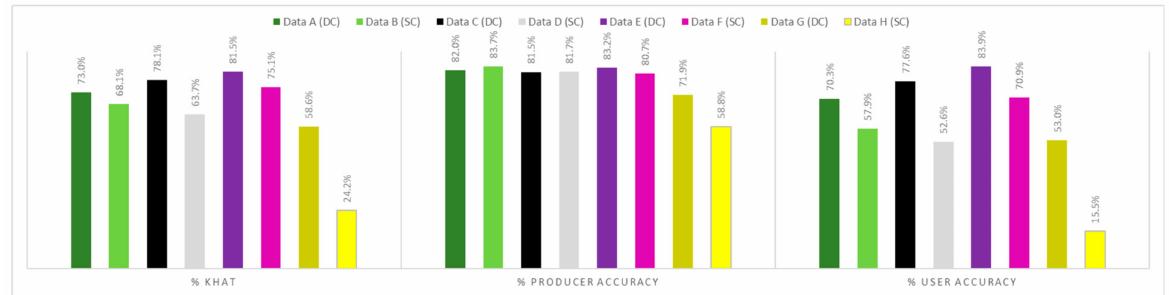
Figure 12. Classification performance for the class landslides (river process excluded) identified by means of the satellite analysis. The area extension of the eight datasets, represented by different colours, is shown in Figure